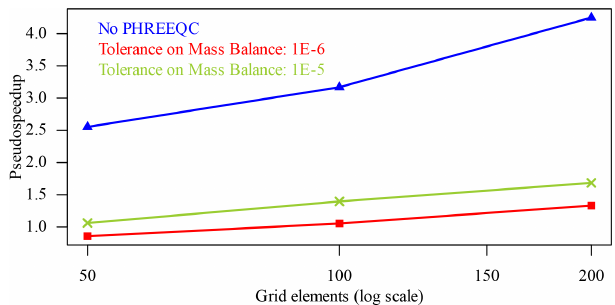
Figure 4. Overall pseudo-speedup (total wall-clock time) after 161 iterations for coupled simulations with hierarchical coupling and only relying on the